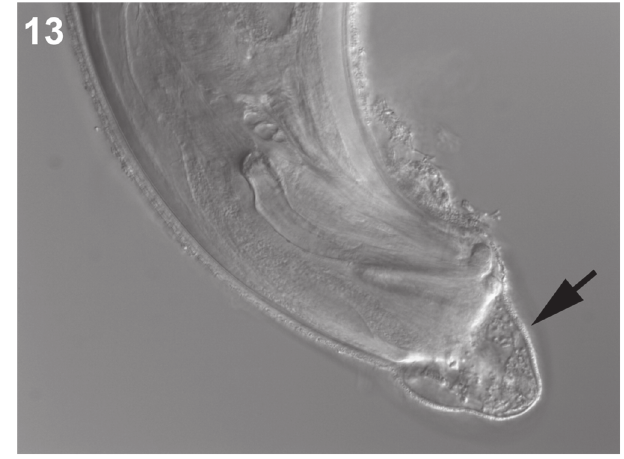
Figure 13. Male, Didelphoxyuris thylamisis , showing extension of postcloacal